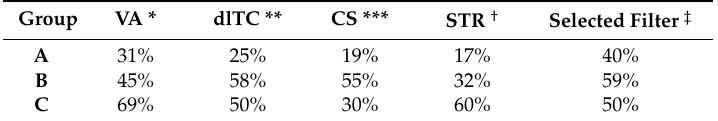
Table 4. Percentage of success in the use of filters in the di ff erent